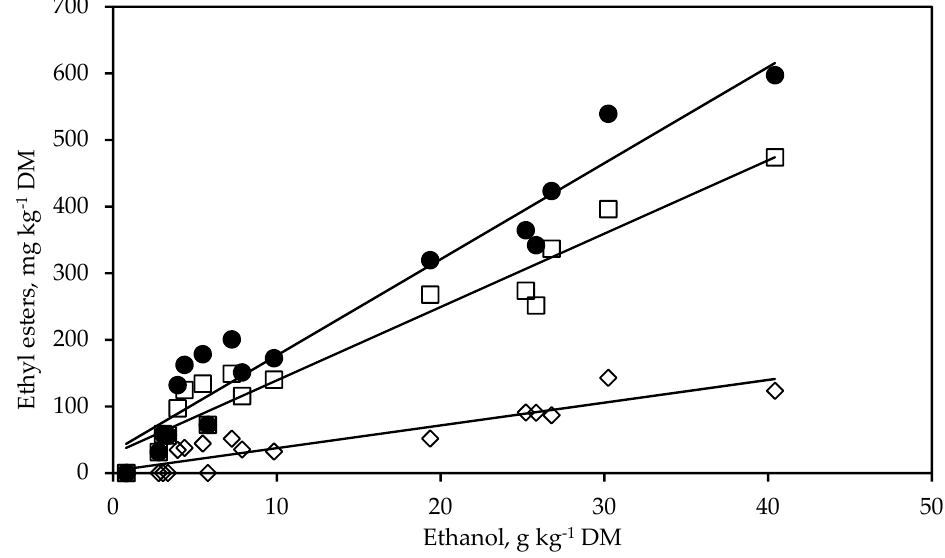
Figure 3. Relationships between the concentration of ethanol and the concentrations of ethyl lactate ( □ , y = 11.01x + 29.10, R 2 = 0.94, RMSE = 33.21, p < 0.001, n = 18), ethyl acetate ( ◊ , y = 3.38x + 3.41, R 2 = 0.85, RMSE = 17.67, p < 0.001, n = 18), and total ethyl esters ( ● , y = 14.42x + 32.48, R 2 = 0.94, RMSE = 45.84, p < 0.001, n = 18) in whole-crop rye silage treated with different additives and stored for 53 days.